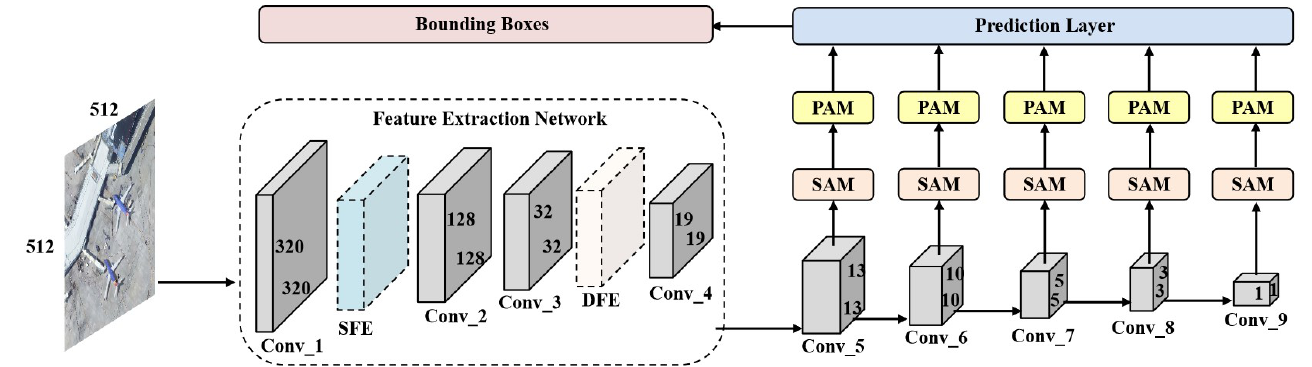
Figure 1. The structure of feature enhancement single shot multiBox detector (FESSD), including the Shallow Feature Enhancement (SFE) Module, Deep Feature Enhancement (DFE) Module, Self- Attention Mechanism (SAM), and Feature Pyramid Attention Mechanism (PAM).